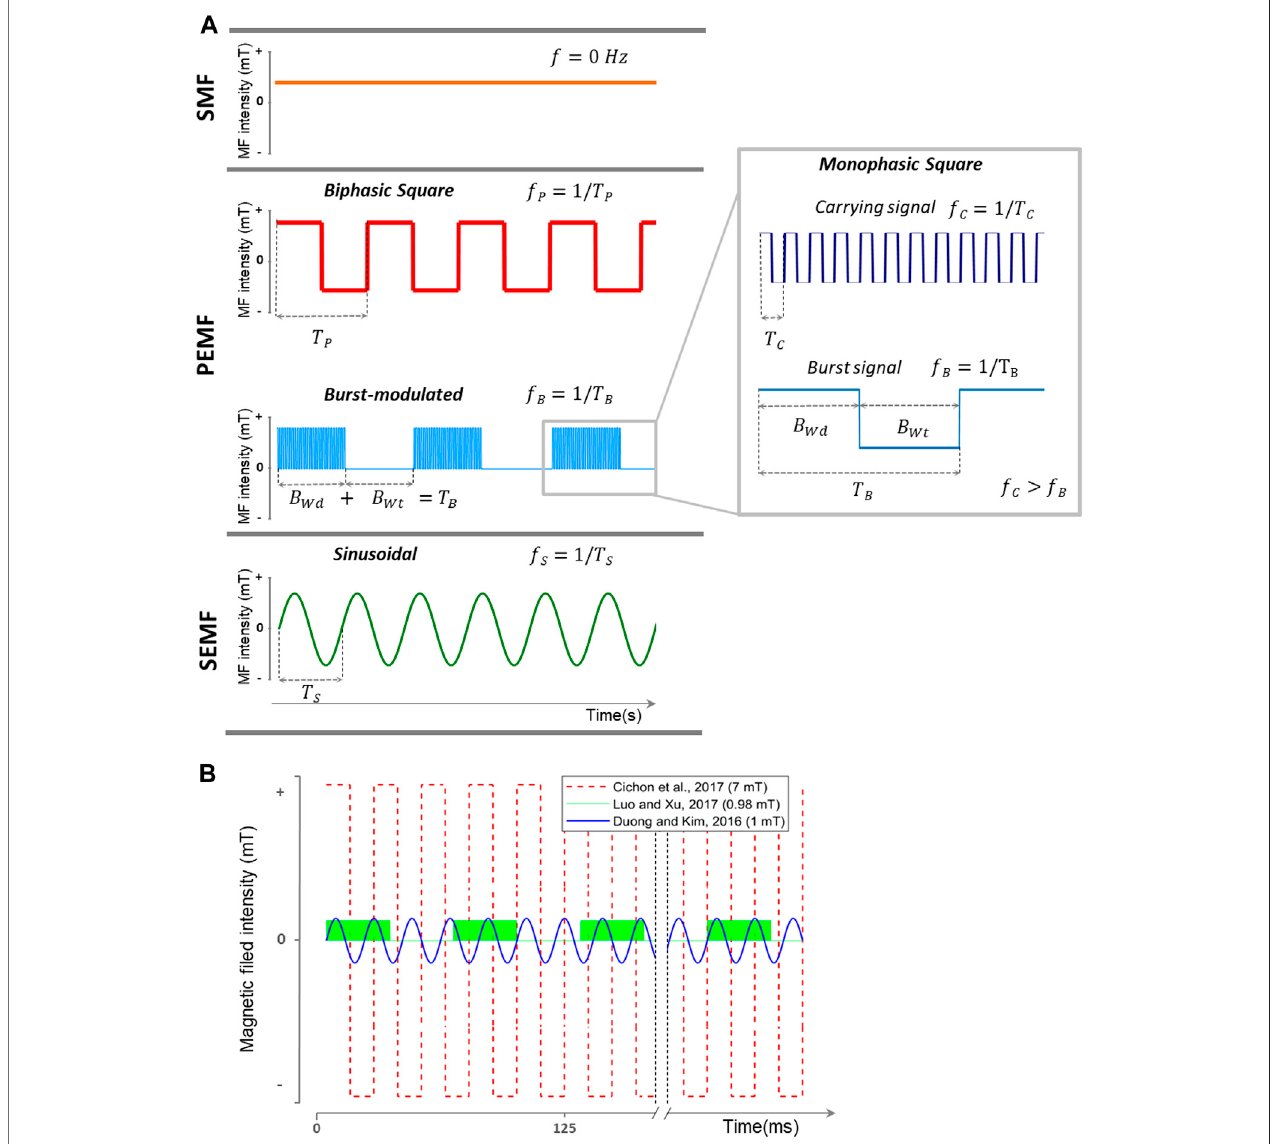
FIGURE 1 | Representation of different types of EMFs used for stroke treatment. (A) EMF classi fi cation used in this article based on waveform and frequency (inverse of the signal period). SMF does not change its magnitude and direction in time ( f (cid:1) 0 Hz). Time-varying EMFs are divided into PEMF and SEMF. PEMFs include non-sinusoidal EMFs. This category includes monophasic square (like the carrying and burst signals), biphasic square, and burst-modulated signals. Burst-modulated signals consist of a carrying signal with a higher frequency modulated by a burst signal with a burst width and burst wait interval at a lower frequency. In this representation, f S > f P > f B . (B) Three of the EMF waveforms used in the consulted literature. In red (Cicho ń et al., 2017a), with a 7 mT/40 Hz biphasic square PEMF. In blue (Duongand Kim, 2016), with a1 mT/50 Hz SEMF. In green (Luo and Xu, 2017), using a burst-modulated PEMF with a burst frequency of 15 Hz (burst width, 5 ms; burst wait, 60 ms) and 4.5 MHz carrying monophasic square signal. SMF: stationary magnetic fi eld; PEMF: pulsed electromagnetic fi eld; SEMF: sinusoidal electromagnetic fi eld; MF: magnetic fi eld; f : frequency; f P : pulse frequency; T P : pulse period; f C : carrying signal frequency; T C : carrying signal period; B Wd : burst width; B Wt : burst wait interval; T B : burst period; f B : burst frequency; f S : sinusoid frequency; T S : sinusoid